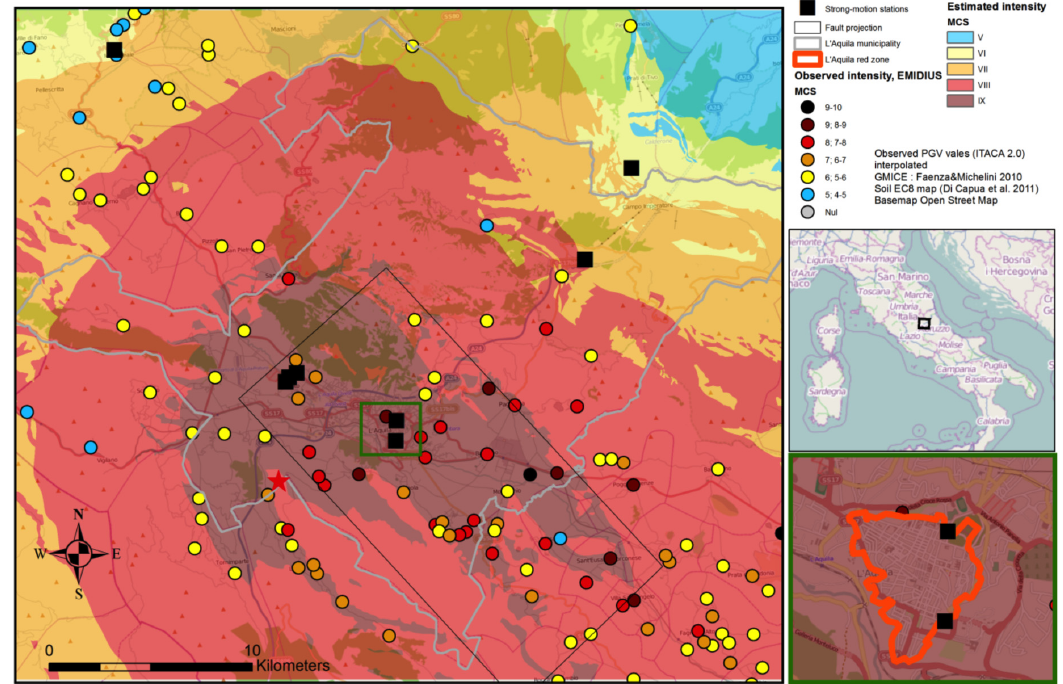
Figure 3. Comparison between hindcast macroseismic intensities using kriging of measured PGV and those observed in L’Aquila